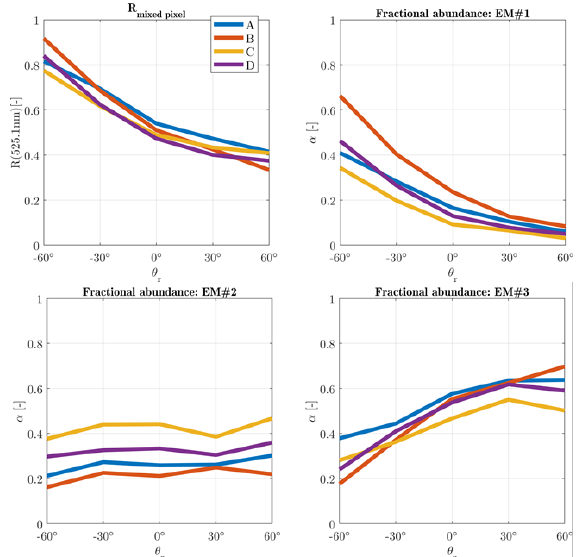
Figure 6. Top left: reflectance values at 525.1 nm as measured from the four patterns, A, B, C, and D, measured from the different viewing angles. The other three tiles present the corresponding estimated fraction for the EMs: EM#1- background, #2-cubes, #3-shadowed areas.